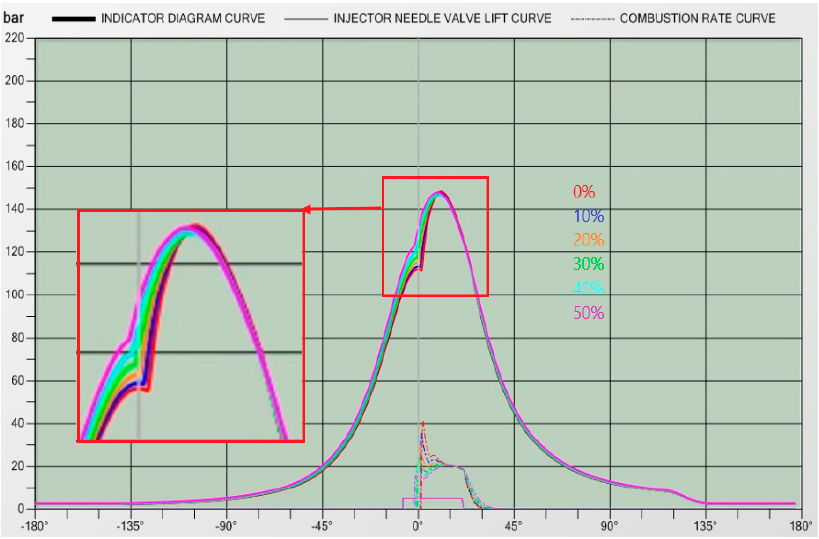
Figure 7. Indicator diagram of blocked cooler tubes.